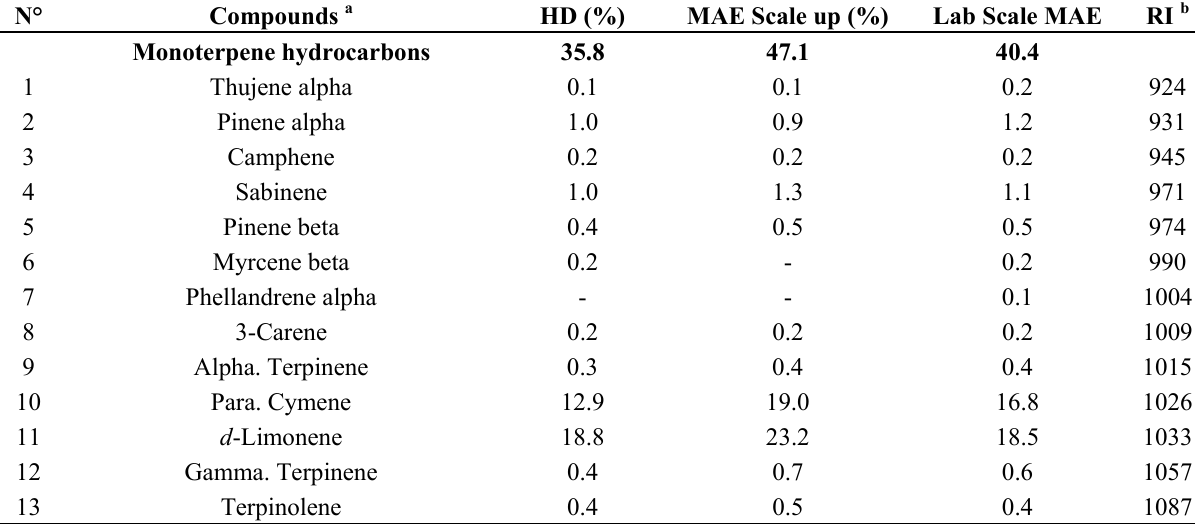
Table 3. Chemical composition of boldo essential oils obtained by hydrodistillation (HD), microwave assisted extraction (MAE), and scale up